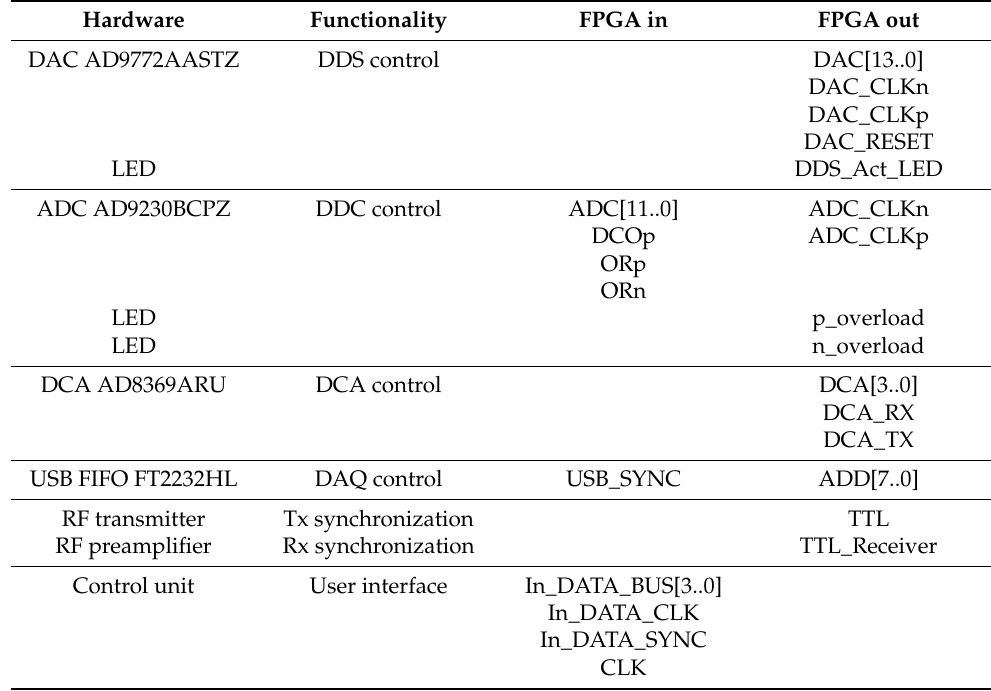
Table 1. Hardware connection mapping